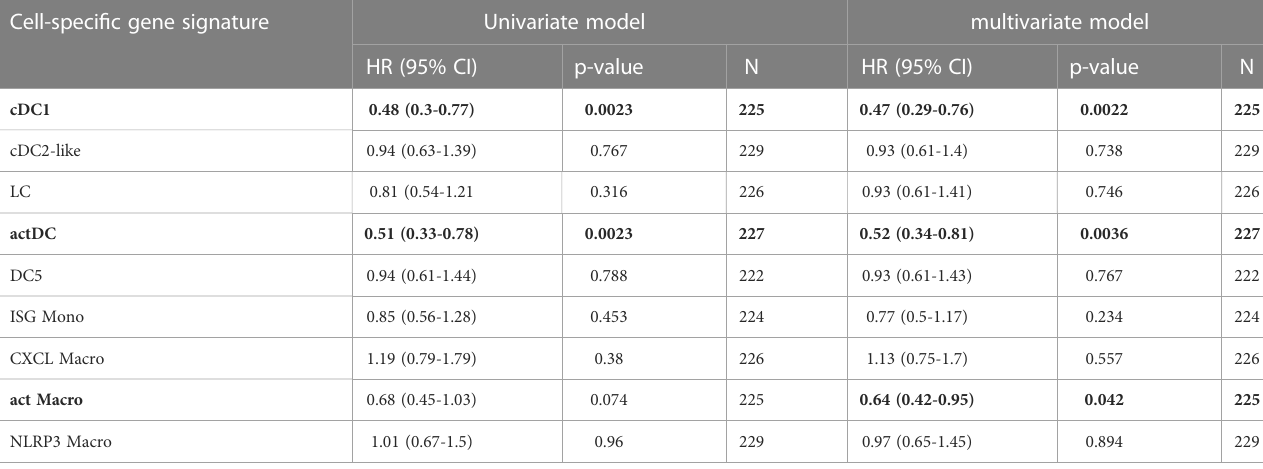
TABLE 1 Adjusted hazard ratios (HR) comparing the fi ve-year overall survival rate between HNC patients with high (Q4) and low (Q1) cluster-speci fi c gene-set scores. Cell-speci fi c gene